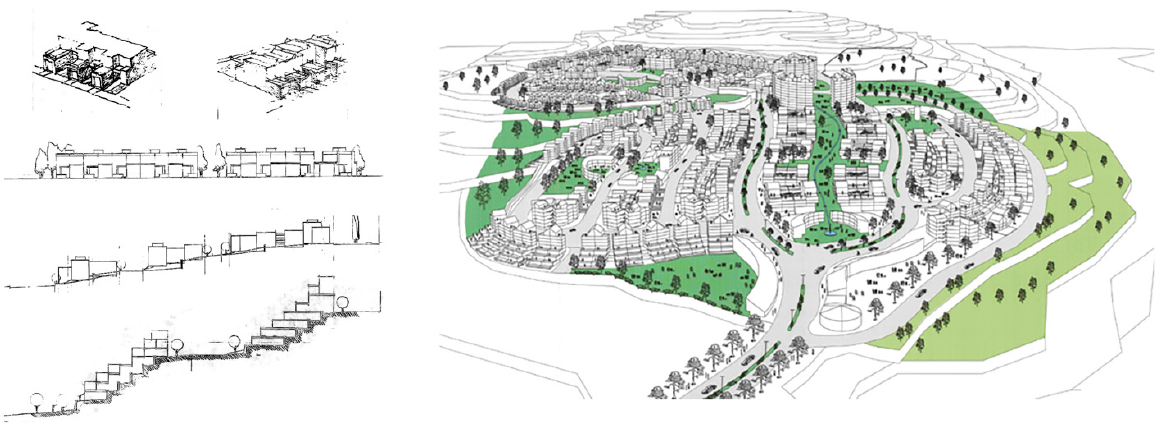
Figure 9. Left: Housing typologies in Harish. Right: Tzur‐Nathan project. Sources: Moshe Zur Architects and Planners (1992) and Meir Nir Architects